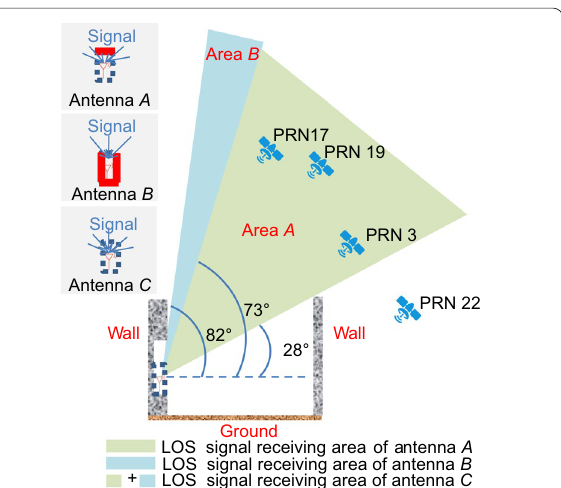
Ground LOS signal receiving area of antenna A LOS signal receiving area of antenna B + Fig. 8 Receiving areas where the LOS signals come from for the three antennas